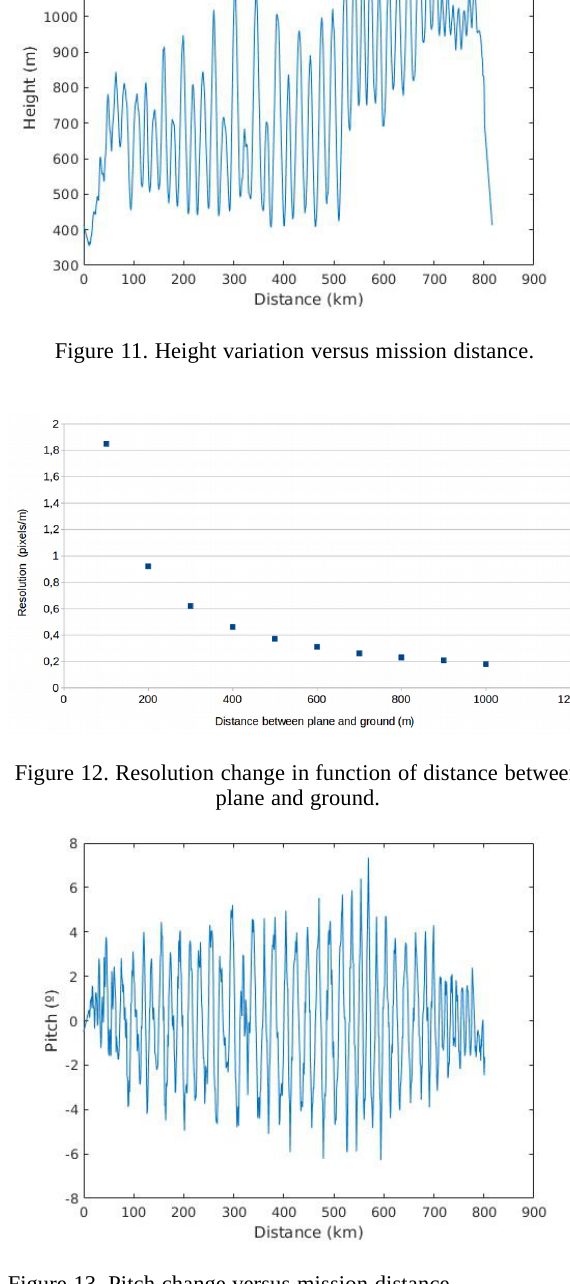
Figure 13. Pitch change versus mission